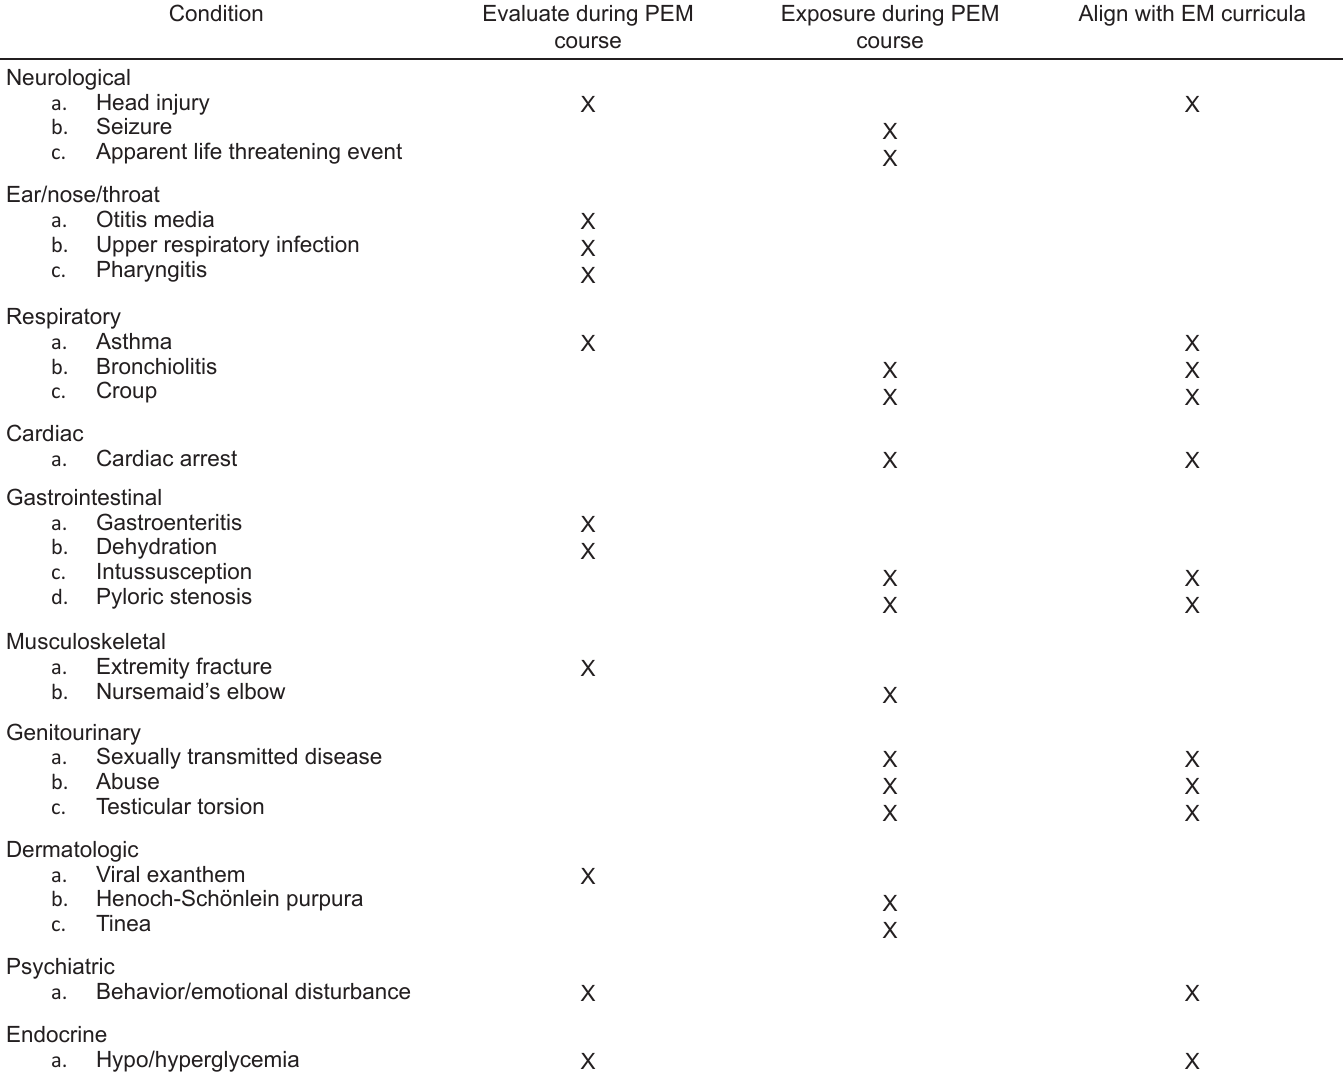
Table 2. Specific conditions by system that students should evaluate clinically or be exposed to during a pediatric emergency medicine (PEM) course and their applicability with national EM